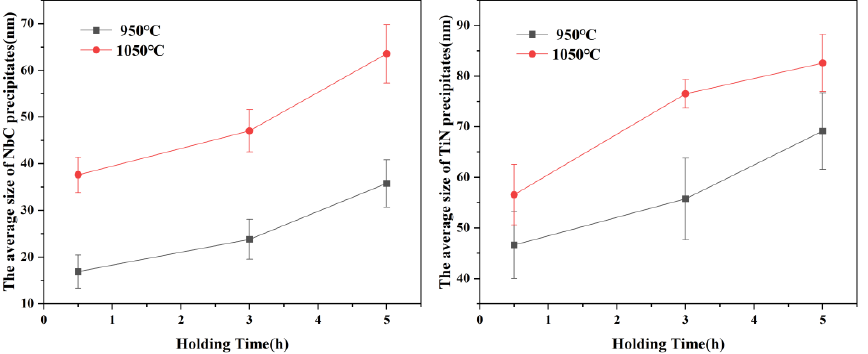
Figure 10. The average size of the precipitates at different temperatures with the extension of hold- ing time.